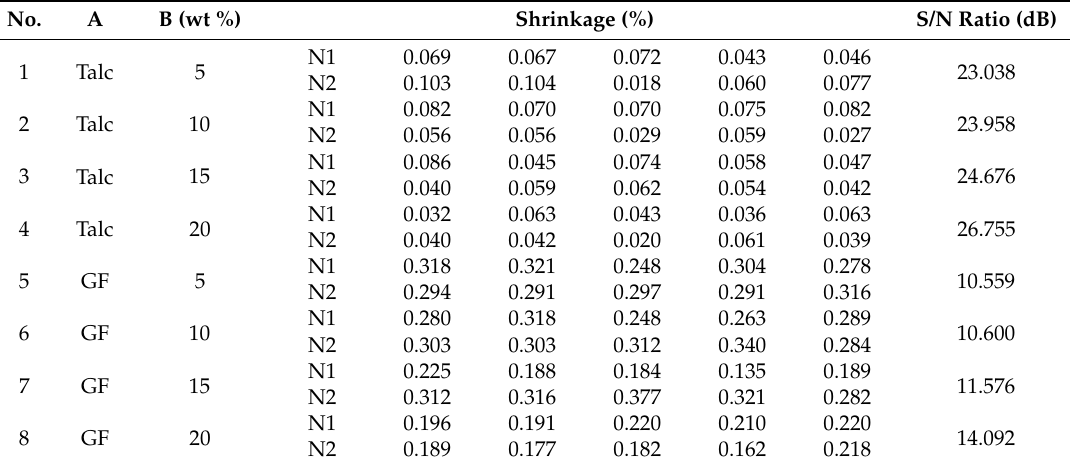
Table 11. S/N ratio of differential